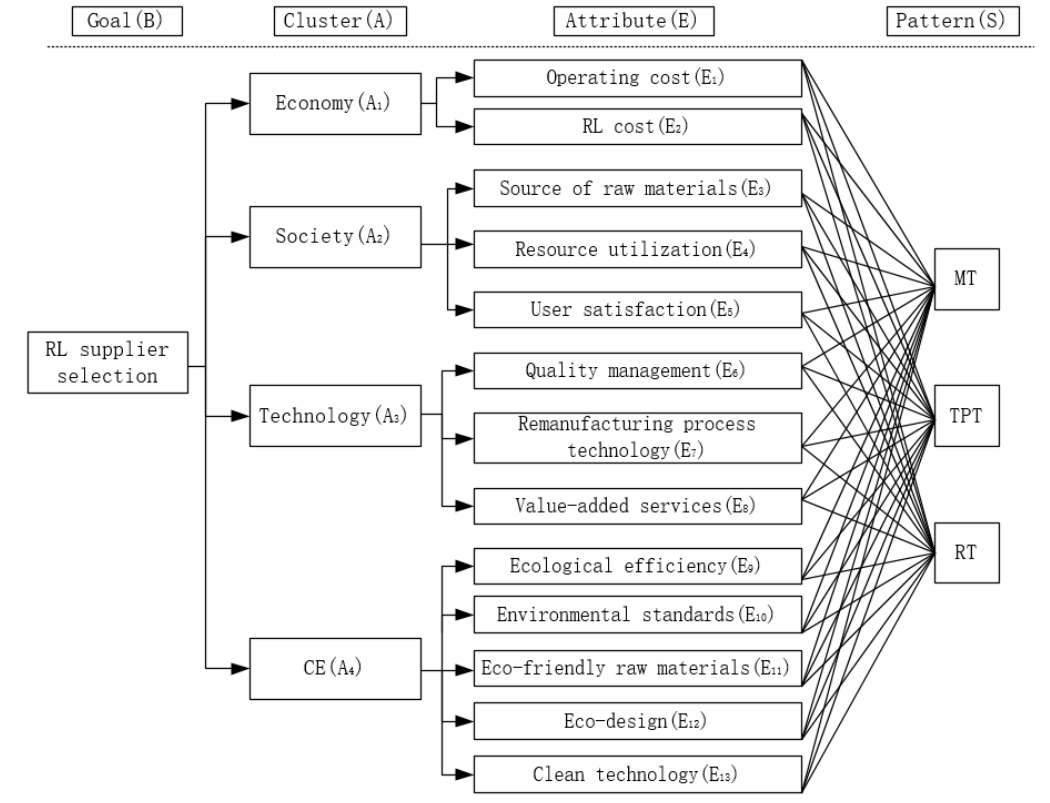
Figure 2. Structure of RL provider selection.